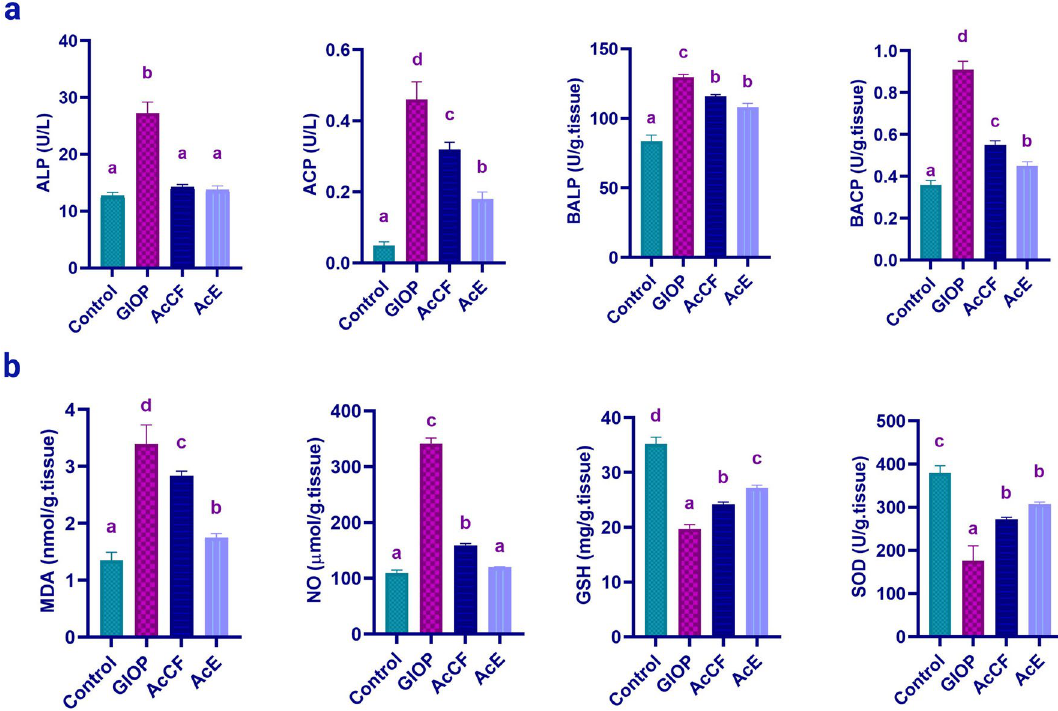
Figure 4. ( a ) Effect of AcCF and AcE on the activity of osteoclast/osteoblast related markers; Serum alkaline phosphatase (ALP), serum acidic phosphatase (ACP), bone alkaline phosphatase (BALP), and bone acidic phosphatase (BACP). ( b ) Effect of AcE and AcCF on oxidative stress markers; malondialdehyde (MDA), nitric oxide (NO), glutathione reduced (GSH), and superoxide dismutase (SOD). Data are expressed as mean ± SD (n = 6 per group), and each value not sharing a common letter superscript is significantly different ( P < 0.05), where ( a ) is the lowest value and ( d ) is the highest